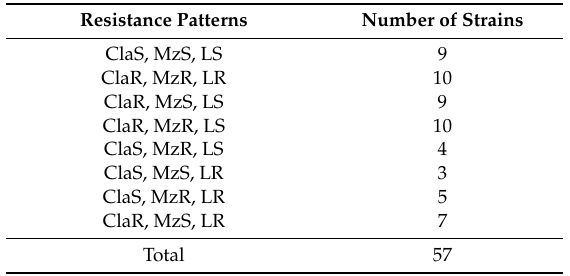
Table 2. H. pylori strains tested with agar well di ff